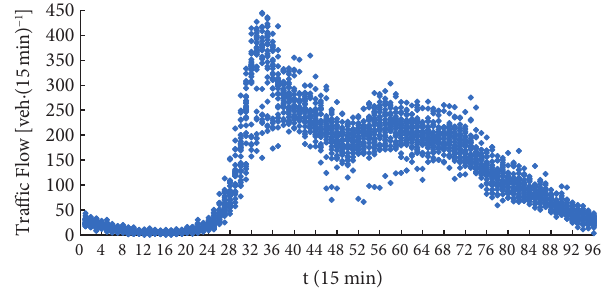
Figure 4: Characteristics of traffic flows during 15 minutes at Guiyang North